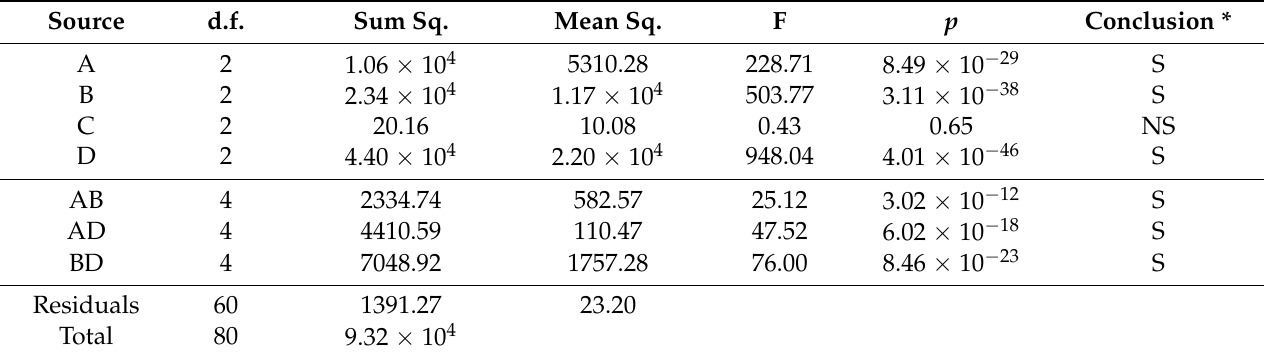
Table 9. Yield strength results for the reduced model four-factor ANOVA.